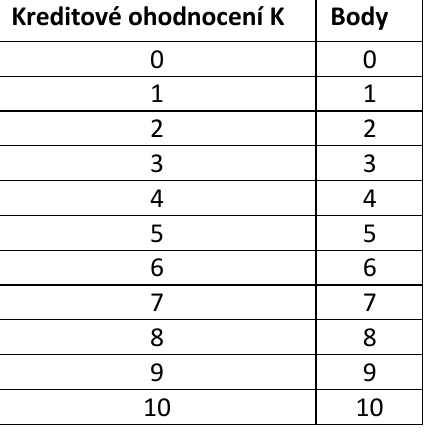
Tabulka 9: Kriteriální meze pro kritérium uživatelská dokumentace (zdroj: